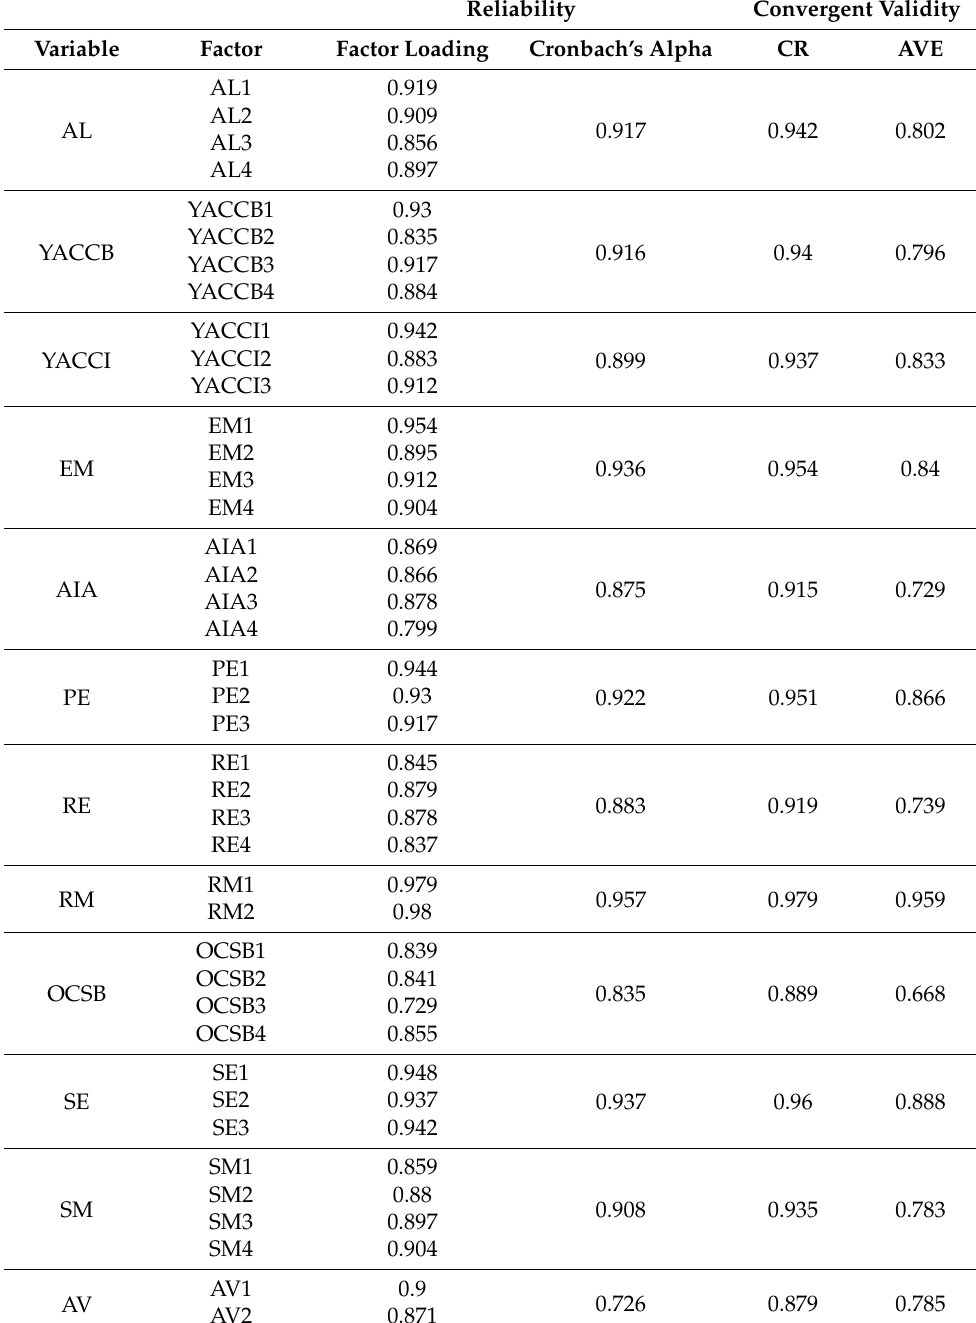
Table 3. Results of reliability and aggregate